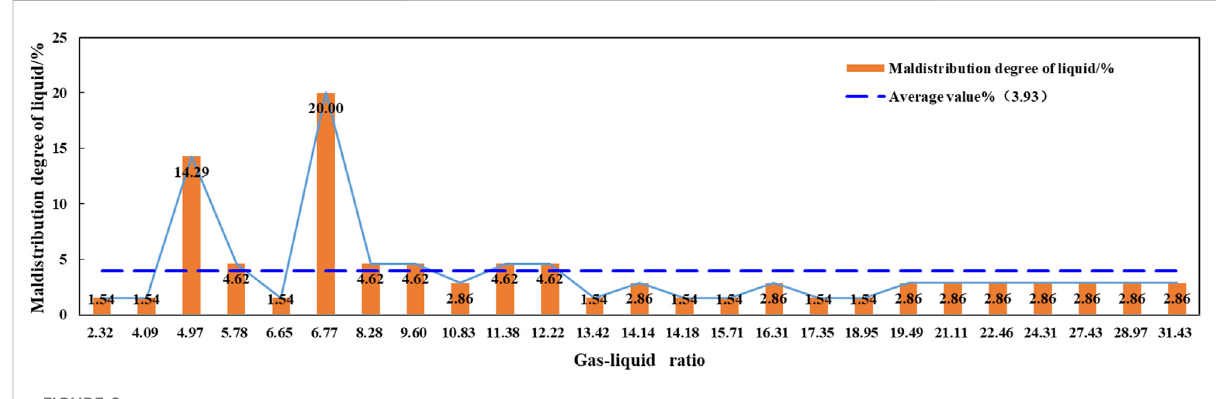
FIGURE 8 Histogramofgas – liquidratioandmaldistributiondegree ofliquidinslug fl owinhorizontalmanifold without fl utepipes(liquidinjectionvolume 0.35L/s+0.65L/s).